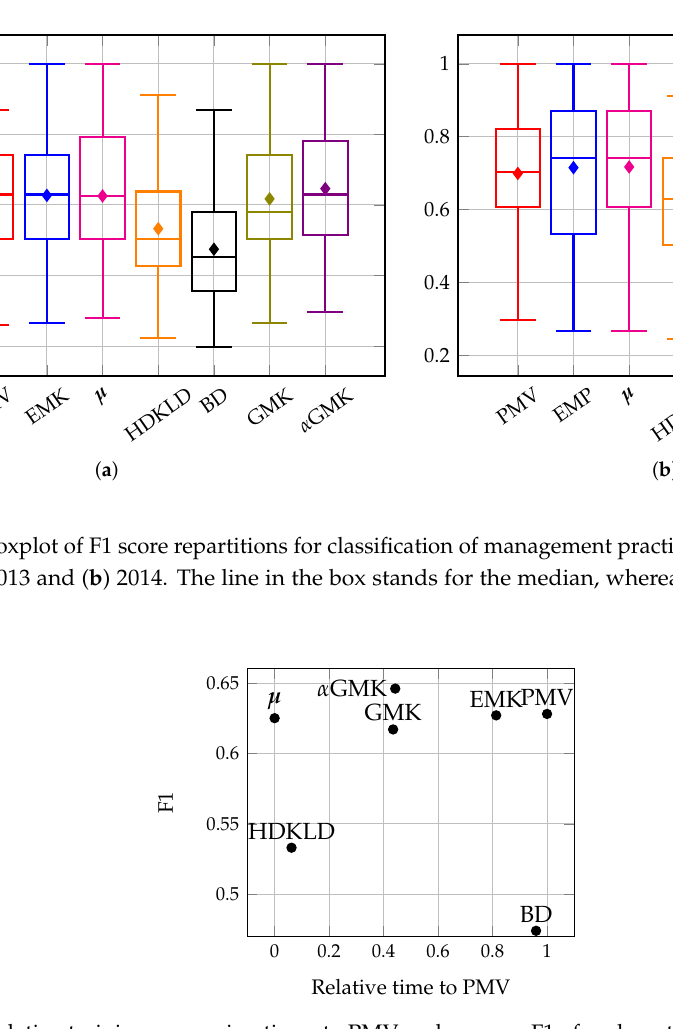
Figure 11. Relative training processing times to PMV and average F1 of each method for intra-annual time series of 2013.